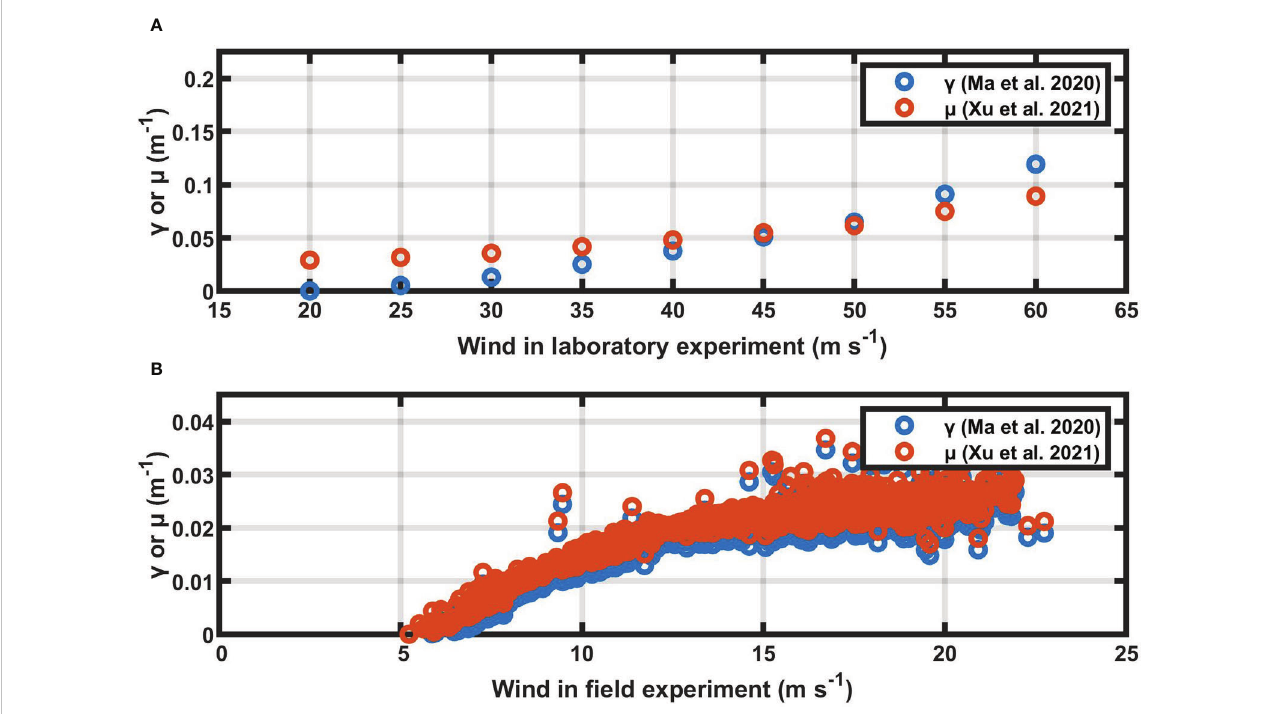
FIGURE 2 Values of the environment variable ( g in Ma et al., 2020, or m in Xu et al., 2021) that derived from laser intensity for the laboratory (A) and fi eld (B) experiments,